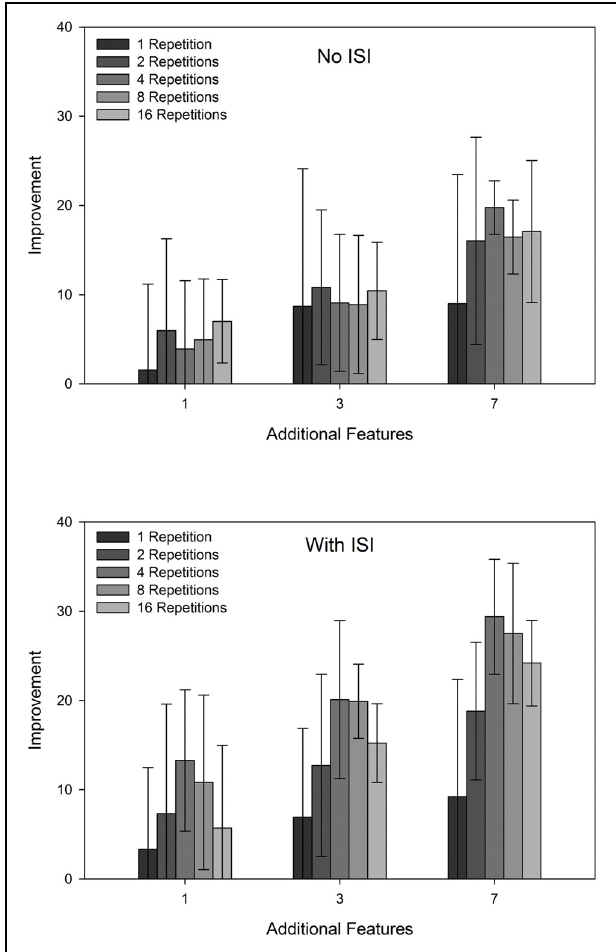
FIGURE 3 | Increase in change detection accuracy associated with additional changing features over the 10 days of each condition as a function of number of additional changes, number of repetitions, and ISI presence. Increases are calculated as accuracy on trials featuring multiple changed minus accuracy on trials featuring a single change. Error bars depict 95% confidence intervals.